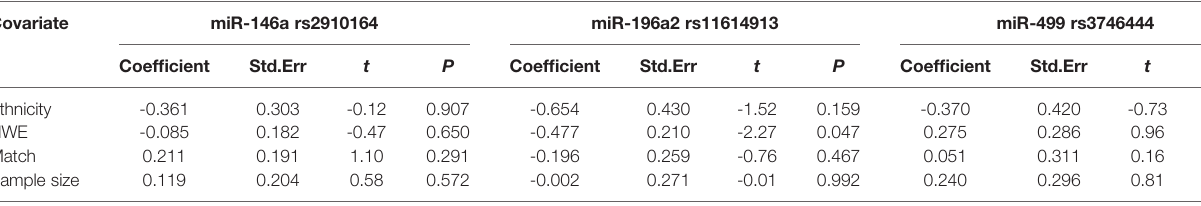
Std.Err, Standard